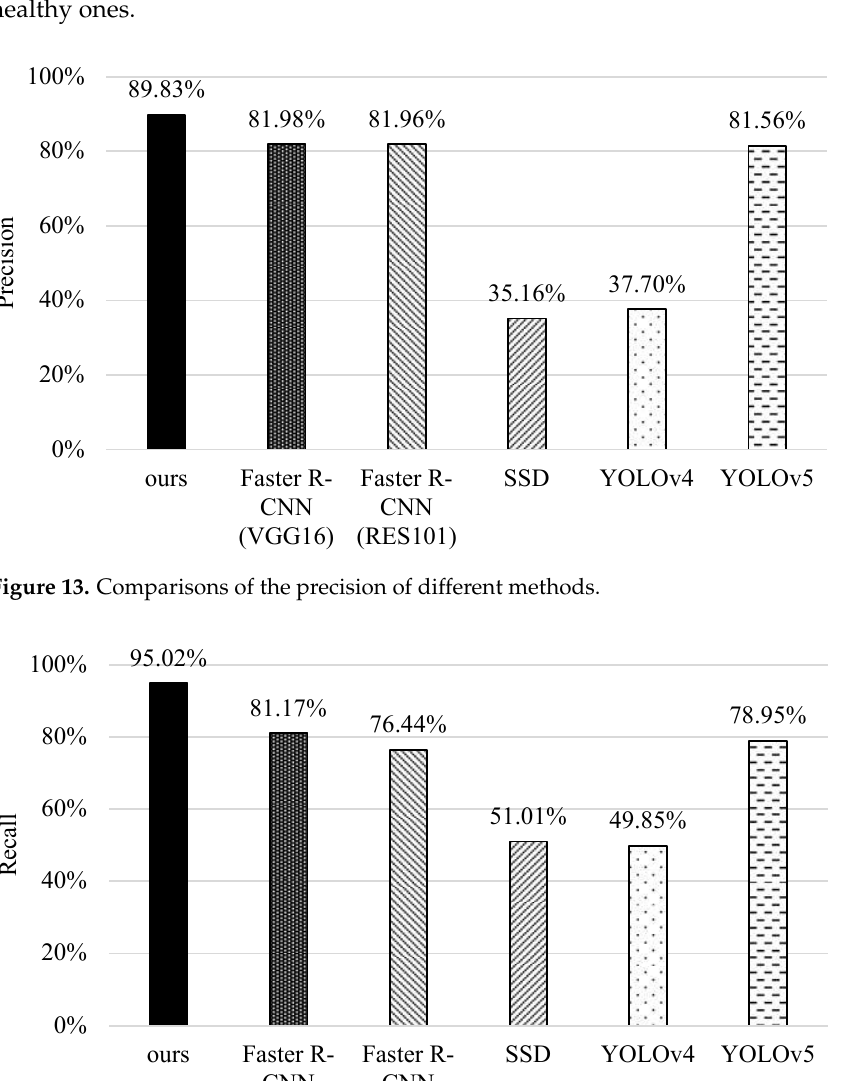
Figure 14. Comparisons of recall of different methods.